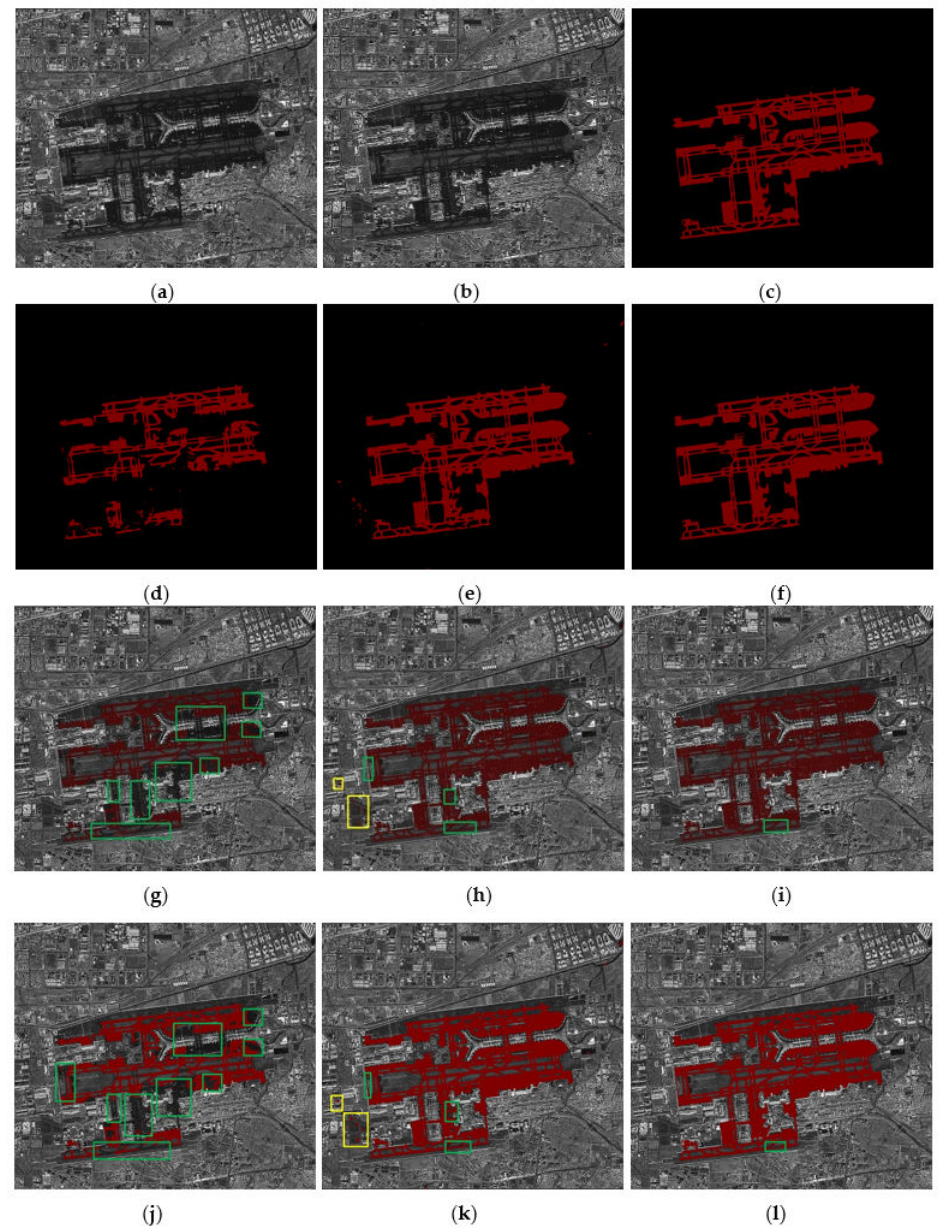
Figure 9. The experiment result for Airport I. ( a ) SAR image of Airport I from Gaofen-3. ( b ) The down-sampled SAR image of ( a ) by 5 times. ( c ) The ground truth of the airport for ( b ). ( d ) The extraction result of ( b ) by RefineNet. ( e ) The extraction result of ( b ) by DeepLabV3. ( f ) The extraction result of ( b ) by MDDA. ( g ) The fusion map of ( d , b ). ( h ) The fusion map of ( e , b ). ( i ) The fusion map of ( f , b ). ( j ) The fusion map of ( a , d ) up-sampled by 5 times. ( k ) The fusion map of ( a , e ) up-sampled by 5 times. ( l ) The fusion map of ( a , f ) up-sampled by 5 times.